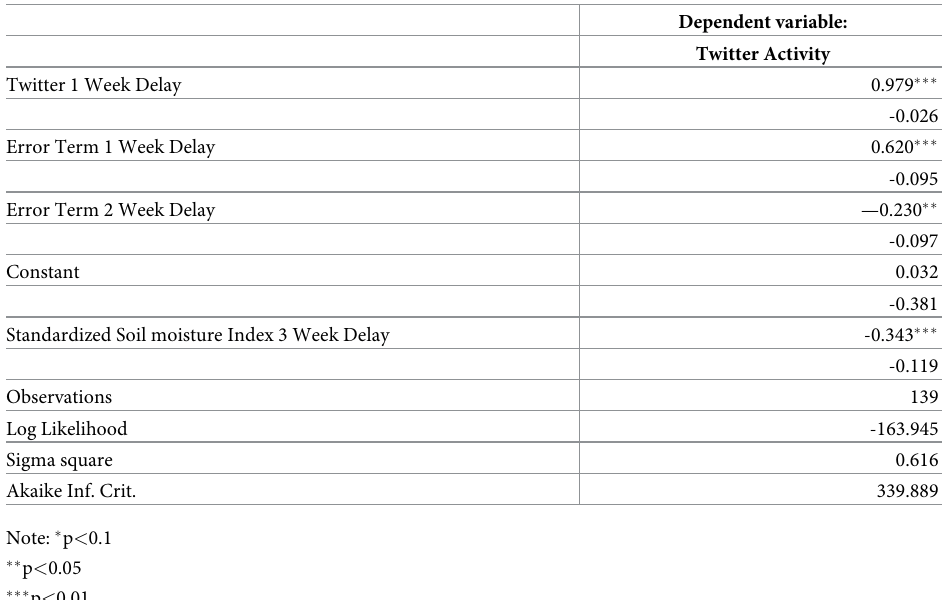
Table 1. Drought severity and Twitter